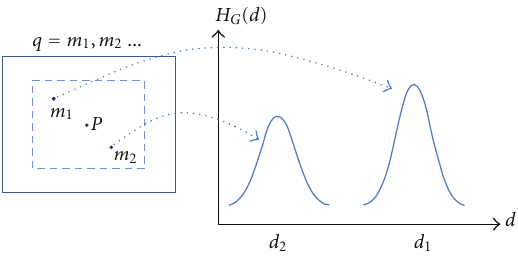
Figure 2: Calculation of the adaptive support function with Gaussian filters. Horizontal axis d represents disparity, H G ( d ) is the Gaussian filter amplitude. Point m 1 above has a larger H G ( d ) value because of closer color-space